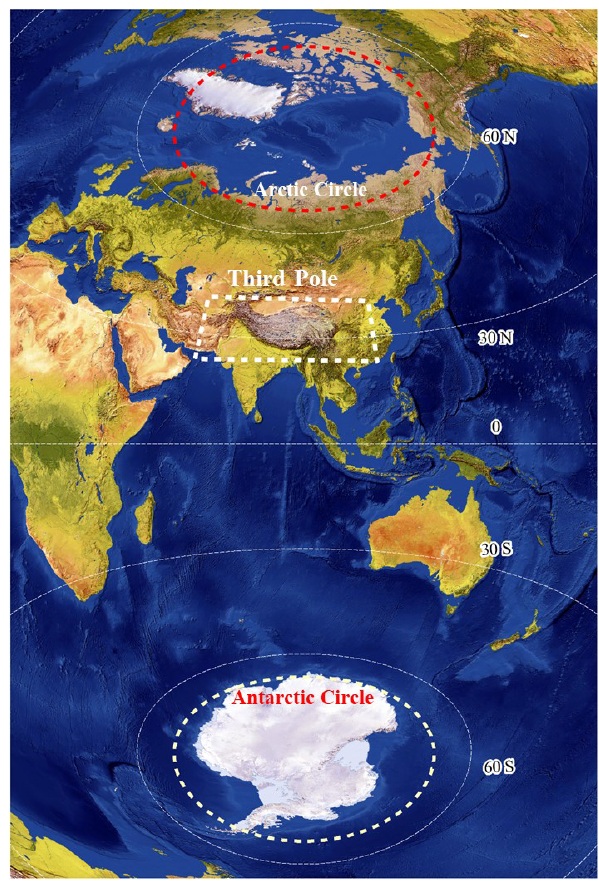
Figure 1. Map of the sampling regions in the three poles. The third pole covers the high mountainous areas in Asia, and data were col- lected in the area from 40 to 23 ◦ N and from 106 to 61 ◦ E (Li et al., 2020). The Arctic covers the areas from the high Arctic to the sub-Arctic, and data were collected from > 60 ◦ N. Data for Antarc- tica were collected from > 60 ◦ S. The latter two regions are indi- cated using different colored circles. (The background of this figure is from